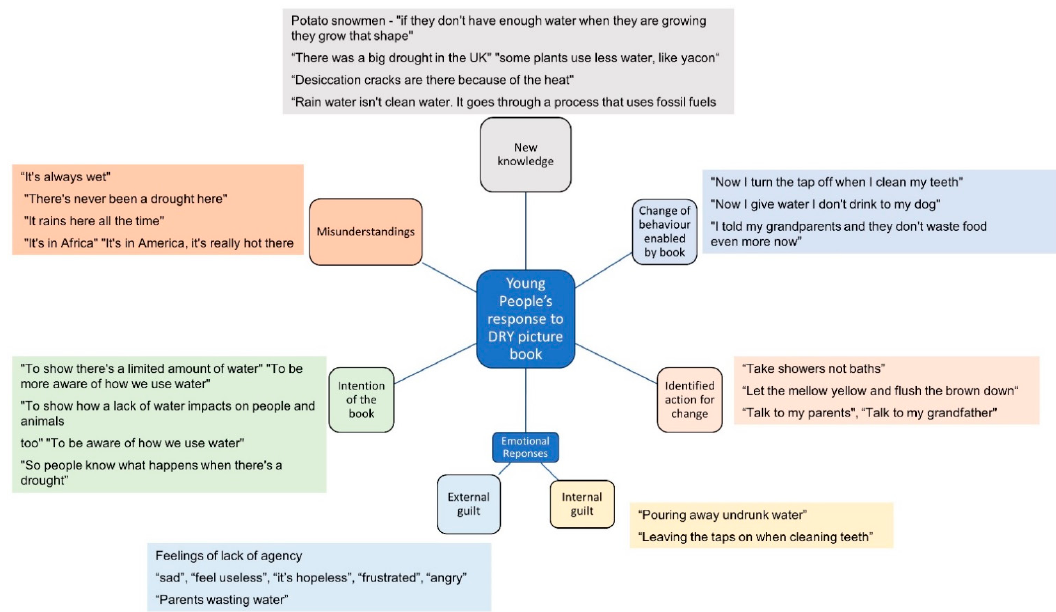
Figure 2. Young people responses to the DRY picture book.